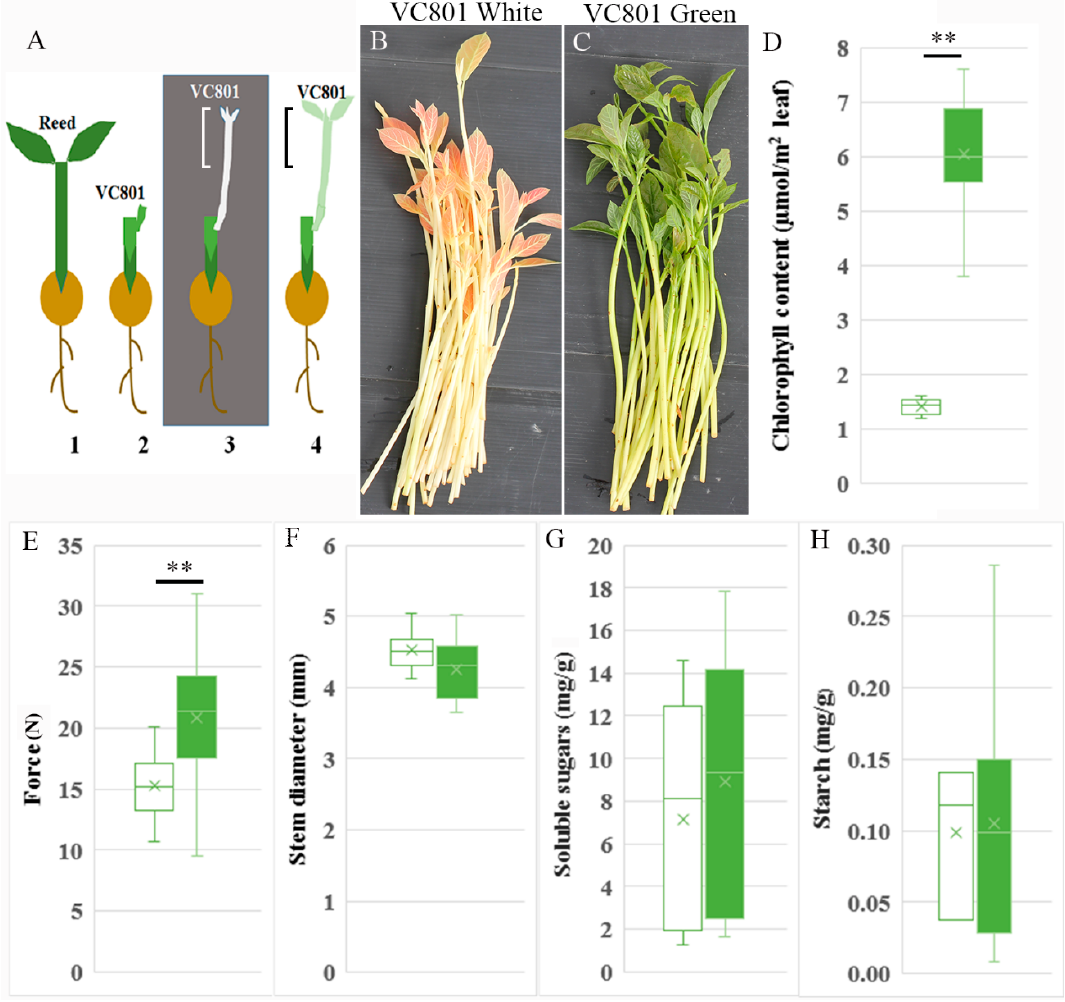
Figure 1. Avocado cuttings used in this study. ( A ) Schematic diagram of the grafted avocado from which the cuttings were taken. 1. A seedling of the nurse rootstock Reed. 2. Grafted VC801 branch with a bud on Reed. 3. The bud of VC801 is elongated in the dark to form an etiolated branch (white). 4. A seedling with an etiolated branch that was transferred to the light for 1–2 weeks (green). The marked portion in 3, and 4 is removed before the second grafting and shown in B and C, respectively. ( B ) Cuttings removed immediately after the etiolation step (1A3). ( C ) Cuttings removed after 1 week in the light (1A4). ( D ) Chlorophyll content. ( E ) Force required to compress the stems by 15% of their diameter. ( F ) Average diameters of the white and green stems. ( G ) Soluble sugar content (glucose, sucrose and fructose). ( H ) Starch content. Number of branches measured in D–F was 10–20, in G–H measurements were done in three replicates, in each three branches equal to 3 g were pooled. Asterisks indicate significant difference by Scheffe test at ** p < 0.01. White and green boxes refer to white and green branches, respectively.